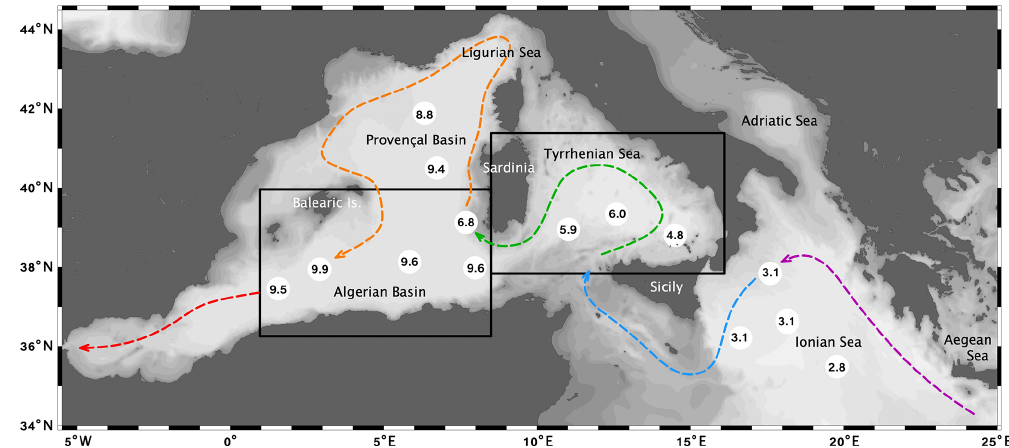
Figure 1. Pathway of LIW in the western Mediterranean (dashed line), crossing the two geographical areas under study (black boxes). Numbers in white circles correspond to the nitrate concentrations (µmolkg − 1 ) in LIW (at the salinity maximum) measured during the cruise